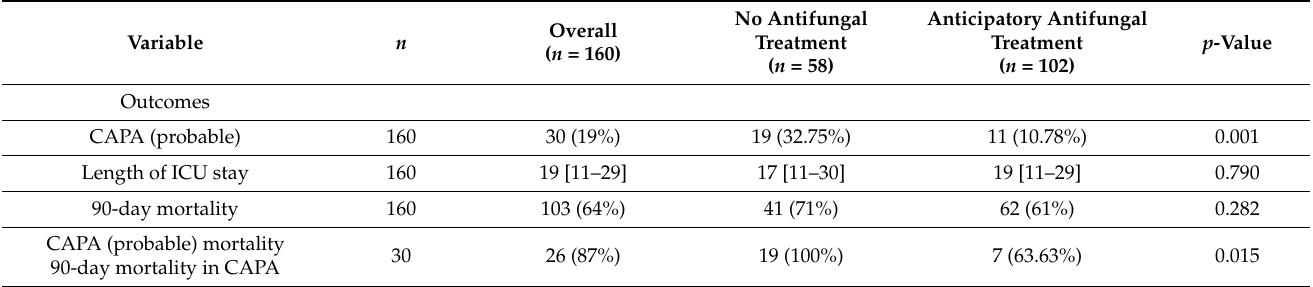
Table 3. Incidence of pulmonary aspergillosis and outcome in the study population.